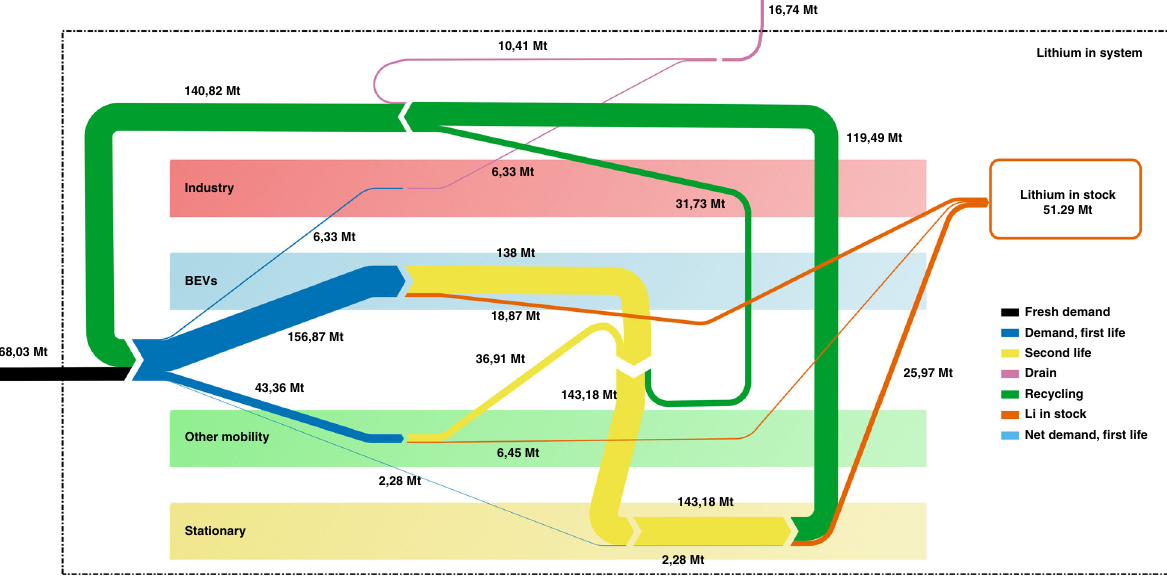
Fig. 5 Lithium fl ow until the year 2100. The material fl ow analysis visualises the sectoral interaction of the integrated demand projection model. The total fi gures of the base case demand are used in this case. Accordingly, 68.03 Mt of in fl owing fresh Li splits into four streams supplying — together with back fl owing recycled material — the demand of the considered fi elds of application. The gross demand of BEVs is quantitatively standing out. A strong fl ow of second-life material is used in the stationary sector, reducing its net demand to 2.28 Mt Li. Except for the material currently used in the year 2100 stock, a strong recycling loop maintains the lion ’ s share of Li in the system. Only 16.74 Mt of Li fl ows out through industrial applications that are not recycled at all and losses within the recycling